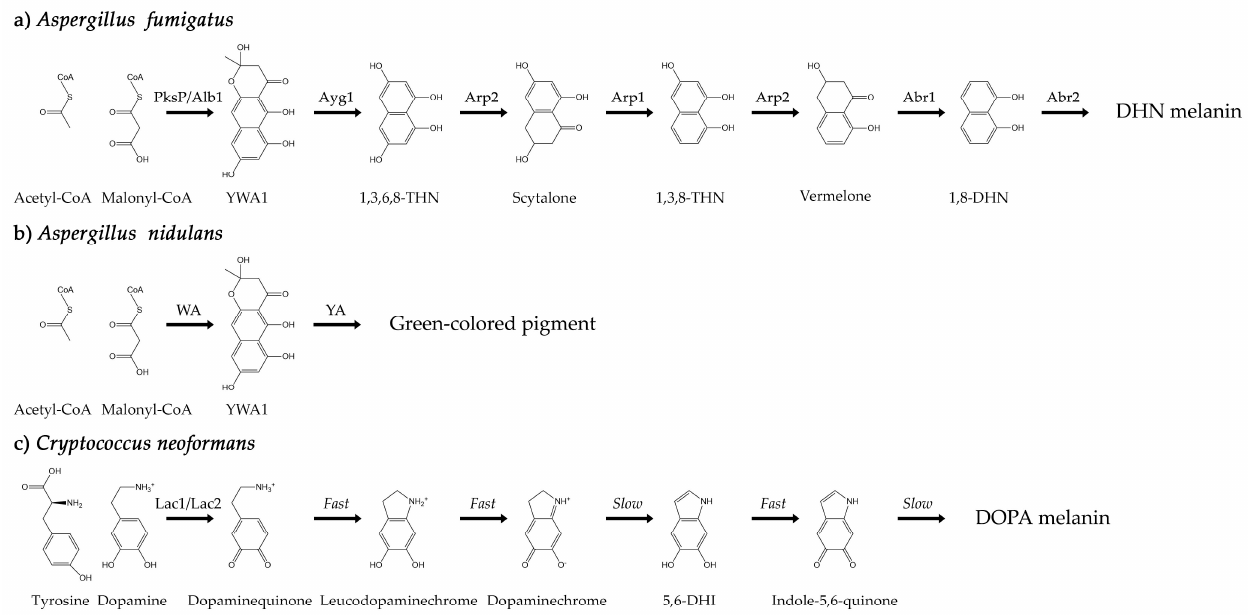
Figure 1. ( a ) The biosynthesis pathway of DHN melanin in A. fumigatus conidia. Acetyl- and malonyl-CoA are converted through a series of reactions catalyzed by six different enzymes. ( b ) The biosynthesis pathway of the green-colored pigment in A. nidulans conidia. Acetyl- and malonyl-CoA are converted through a series of reactions involving the WA and YA enzymes. The final product has not yet been fully characterized. ( c ) The biosynthesis pathway of DOPA melanin in C. neoformans cells. The initial conversion of tyrosine or dopamine to dopaminequinone is catalyzed primarily by the Lac1 enzyme. Subsequent reactions occur through a Raper–Mason scheme.